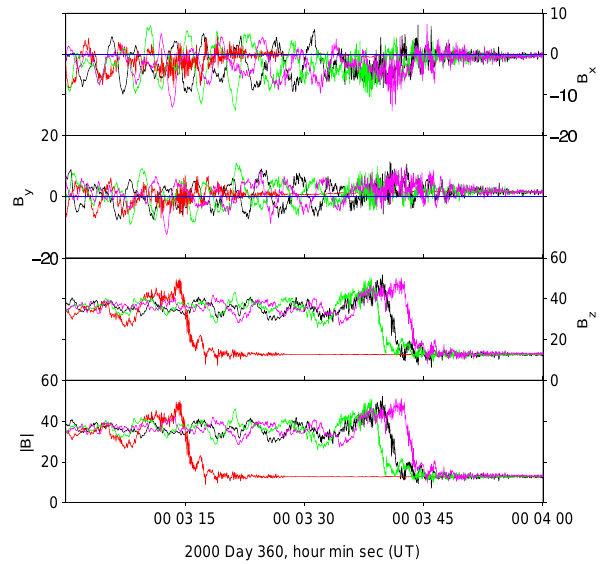
Fig. 3. High resolution (22 vectors/s) GSE magnetic field at all four Cluster spacecraft during a quasi-perpendicular bowshock crossing. Traces for each spacecraft are shown in a different colour: black, red, green and magenta for spacecraft 1, 2, 3 and 4,